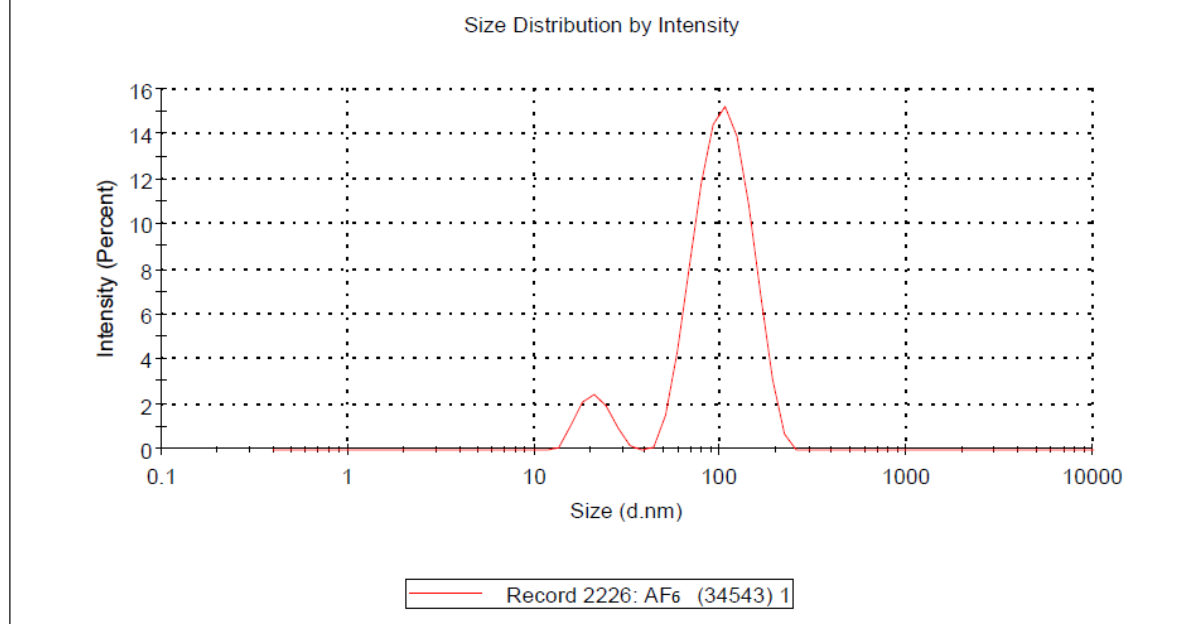
Figure 2. Particle size distribution curve of AF6. Table 3. Mean particle size (nm), zeta potential (mV), and polydispersity index (PI) of different ALP formulations.